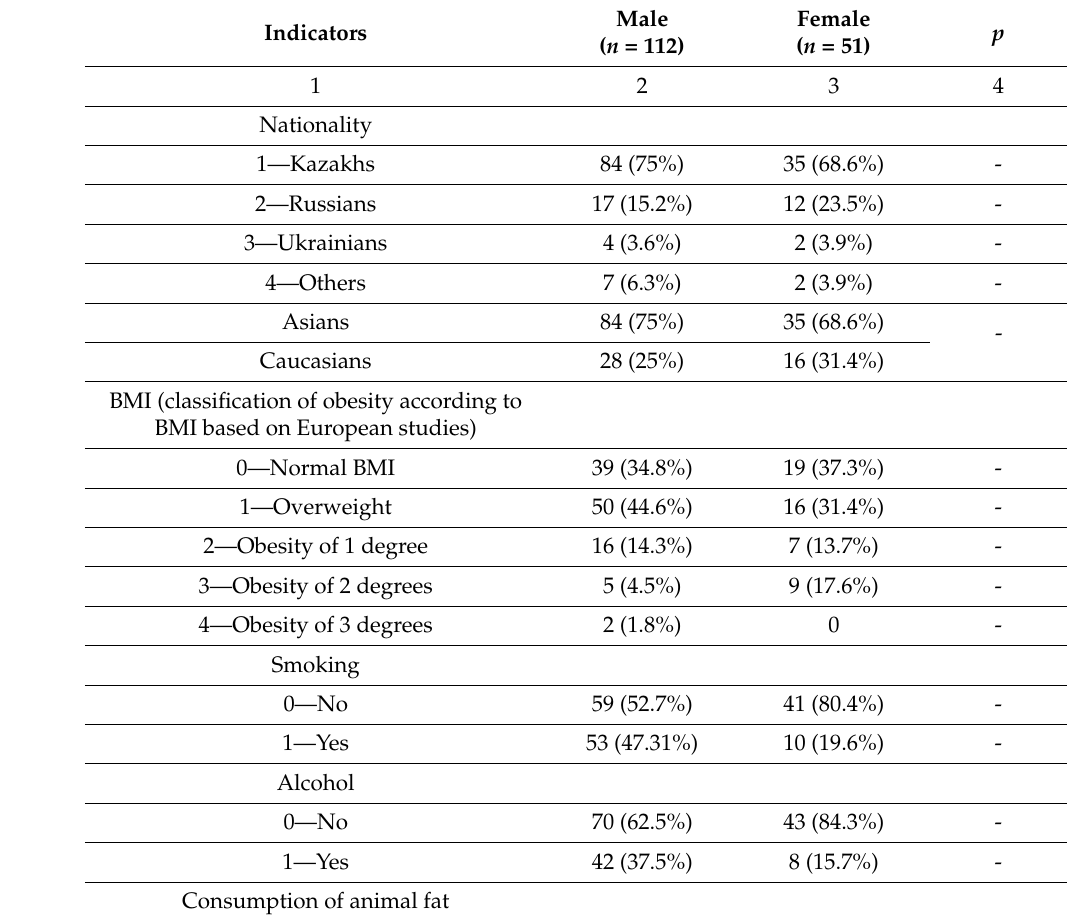
Table 1. Comparative characteristics of general clinical data and laboratory parameters depending on gender in the main